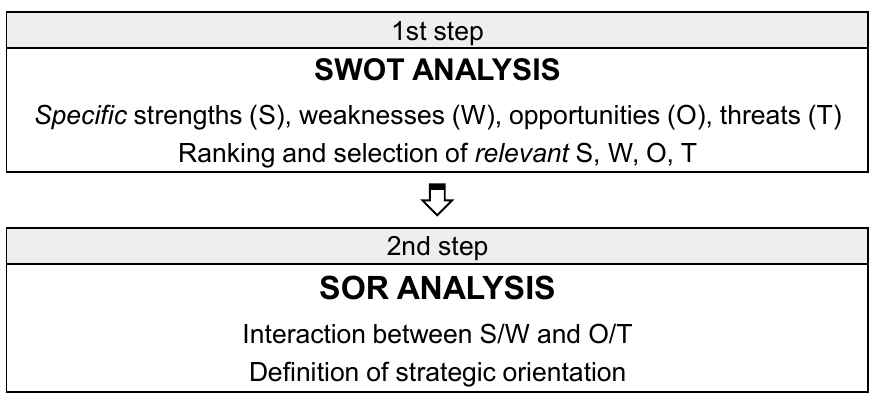
Figure 2. Framework of SWOT-SOR analysis.